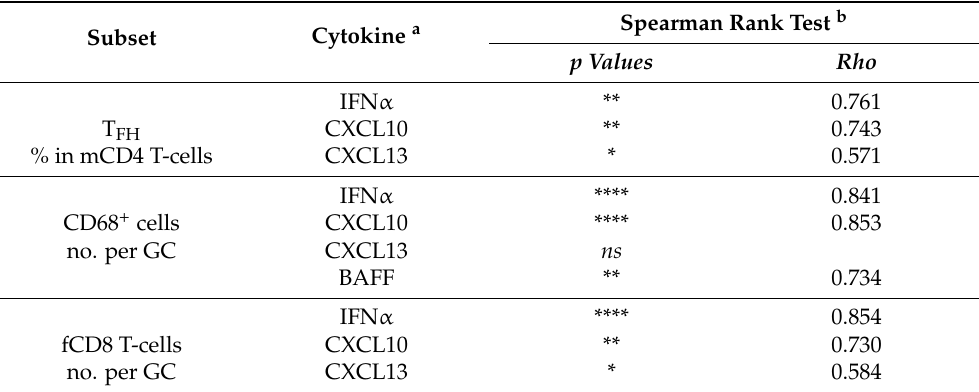
Table 2. Correlation between cytokine titers in blood and frequencies of T-cell subsets and monocytes in spleen